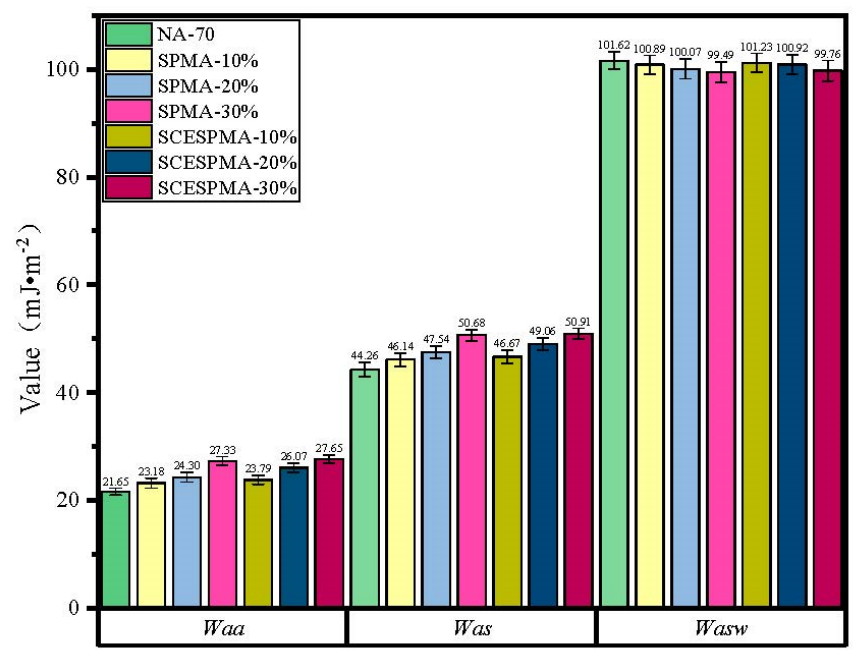
Figure 16. Relationship between γ l and γ l cos θ .